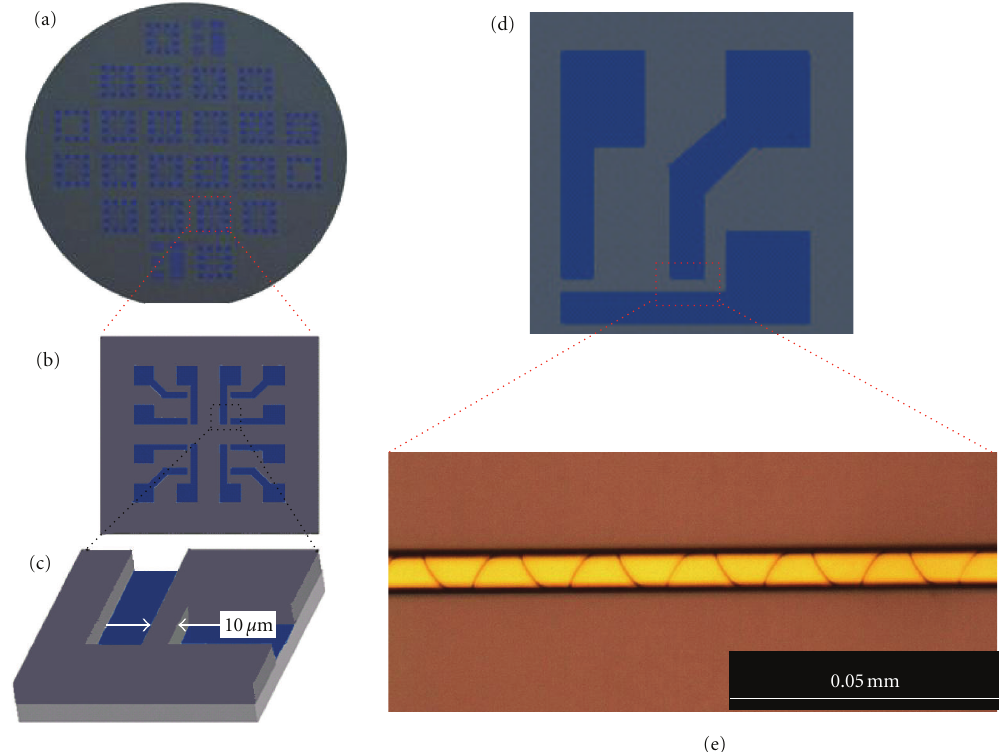
Figure 4: (a) Optical image of a microstructured photoresist film consisting of several microchips on a silicon wafer and a magnified view of a microchip. After UV lithography, each individual chip (b) consists of an open area for the later installed contact lines on the SiO 2 and a 10 μ m wide rectangle of photoresist (c), where the nanowires will be installed. (d) Part of a chip cut from a chip design. (e) An optical micrograph of the 10 μ m wide and 200 μ m long photoresist after it is thermally fractured in liquid nitrogen—a periodic pattern of cracks occur. The cracks in (e) are observable optically as they are bended upwards because of the debonding of the resist from the substrate and causing it a